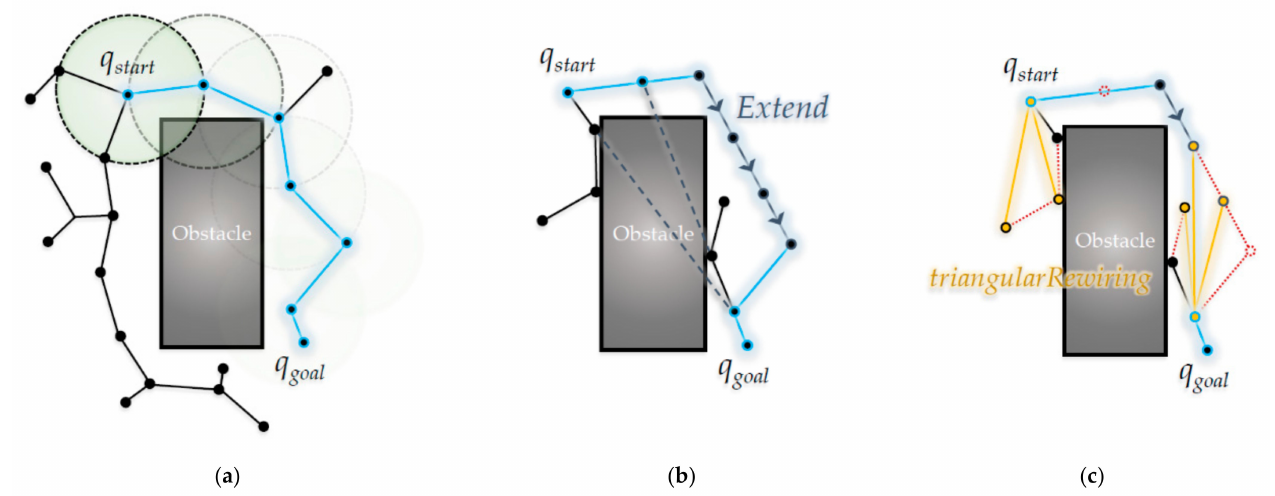
Figure 1. Overview of the algorithms in this paper: ( a ) RRT; ( b ) RRT-Connect; ( c ) the proposed